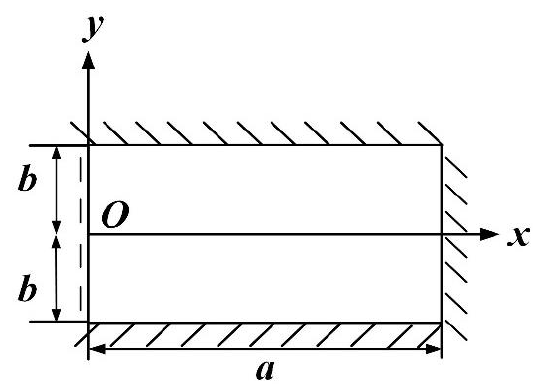
Figure 6. ‘Plate’ mechanical model of initial fracture of roof.